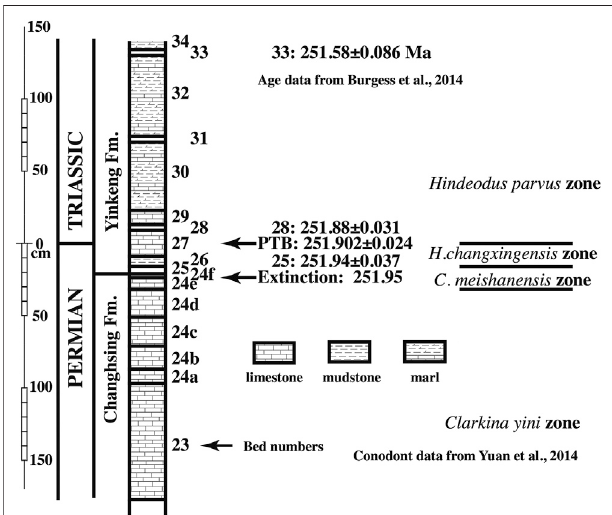
FIGURE1| Meishanstratigraphicsection,withthemeasurementdatum setatthePTBatthetopofbed27b.U/PbzircondatesarefromBurgessetal. (2014). Conodont zones are from Yuan et al. (2014). Sampling for this study extends from bed 24a to bed 34, from -95 to 140 cm, with 63 of 64 samples being between − 95 and 60